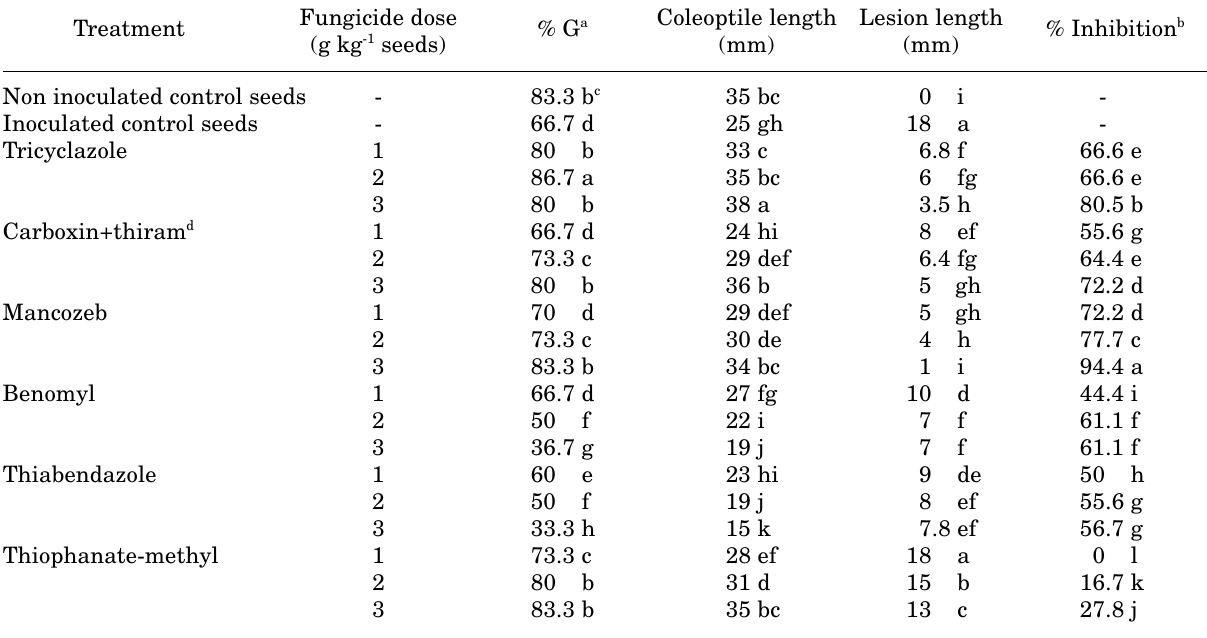
Table 2. Percentage seed germination, coleoptile length, coleoptile lesion length and percent inhibition of lesions on coleoptiles. Seeds were treated with fungicides and inoculated 24 hours later with Helminthosporium oryzae. Fungicide Treatment